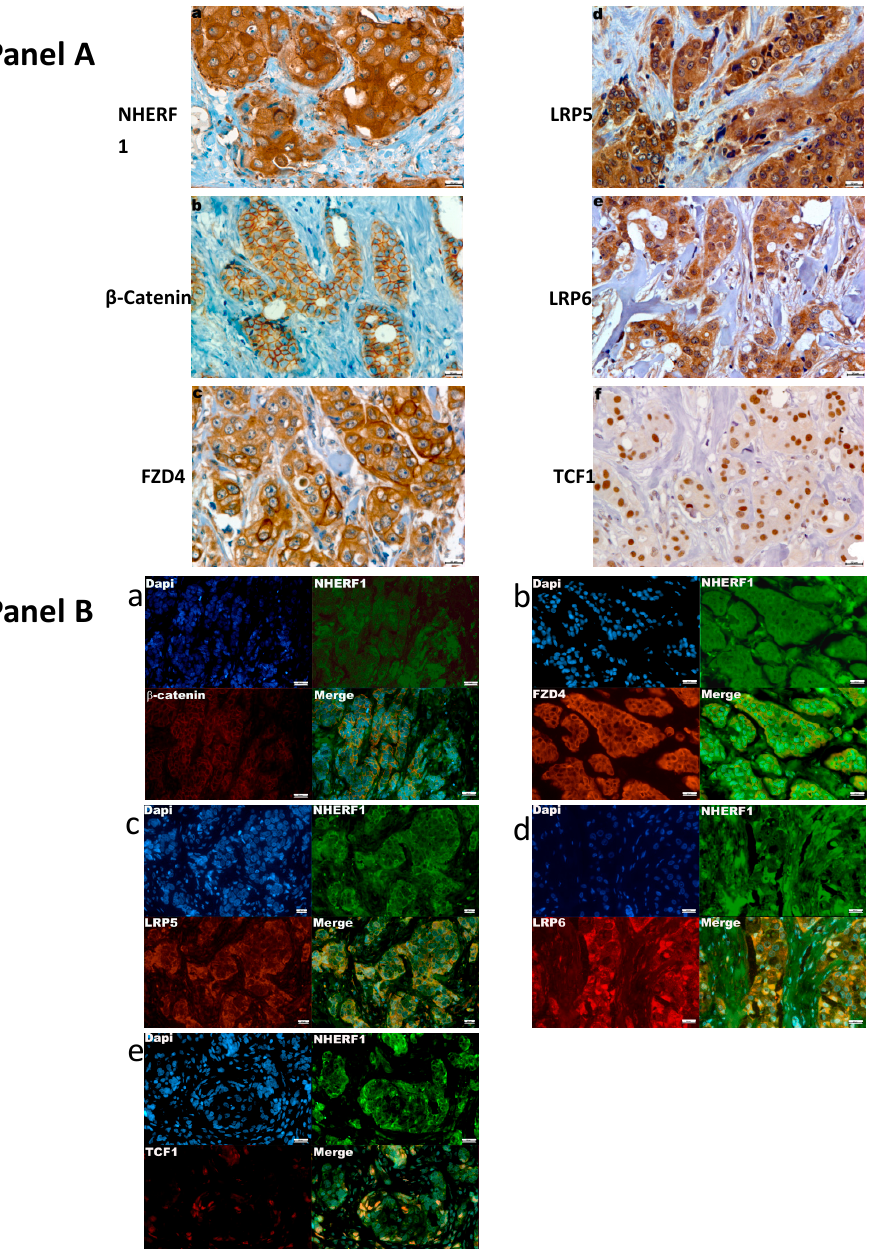
Figure 1. Panel A. Representative images of immunohistochemical staining in Breast Cancer tissues. The panel displays the representative expression of molecular biomarkers in tumor zone: ( a ) positive high cytoplasmic Na+/H+ Exchanger Regulatory Factor 1 (NHERF1) expression; ( b ) membranous and cytoplasmic β -catenin expression; ( c ) cytoplasmic Frizzled receptor 4 (FZD4) overexpression; ( d ) and ( e ) cytoplasmic Low-density lipoprotein receptor-related protein (LRP) 5 and Low-density lipoprotein receptor-related protein (LRP) 6 overexpression; ( f ) nuclear T-cell factor 1 (TCF1) expression (original magnification, × 400). Scale bar = 20 µ m. Panel B. Immunofluorescence assay of the expression of NHERF1 and Wnt / pathway proteins. Representative tumor tissue samples stained with: ( a ) NHERF1 and β -catenin; ( b ) NHERF1 and FZD4; c) NHERF1 and LRP5; ( d ) NHERF1 and LRP6; ( e ) NHERF1 and TCF1 primary antibodies and detected with Alexa Fluor 488 (green) and Alexa Fluor 568 (red) secondary antibodies. The nuclei were stained with DAPI (4 (cid:48) ,6-diamidino-2-phenylindole, blue) (original magnification, × 400). Scale bar = 20 µ m. Images were obtained on an Axion Image 2 upright microscope (Zeiss, Oberkochen, Germany) with an Axiocam 512 color